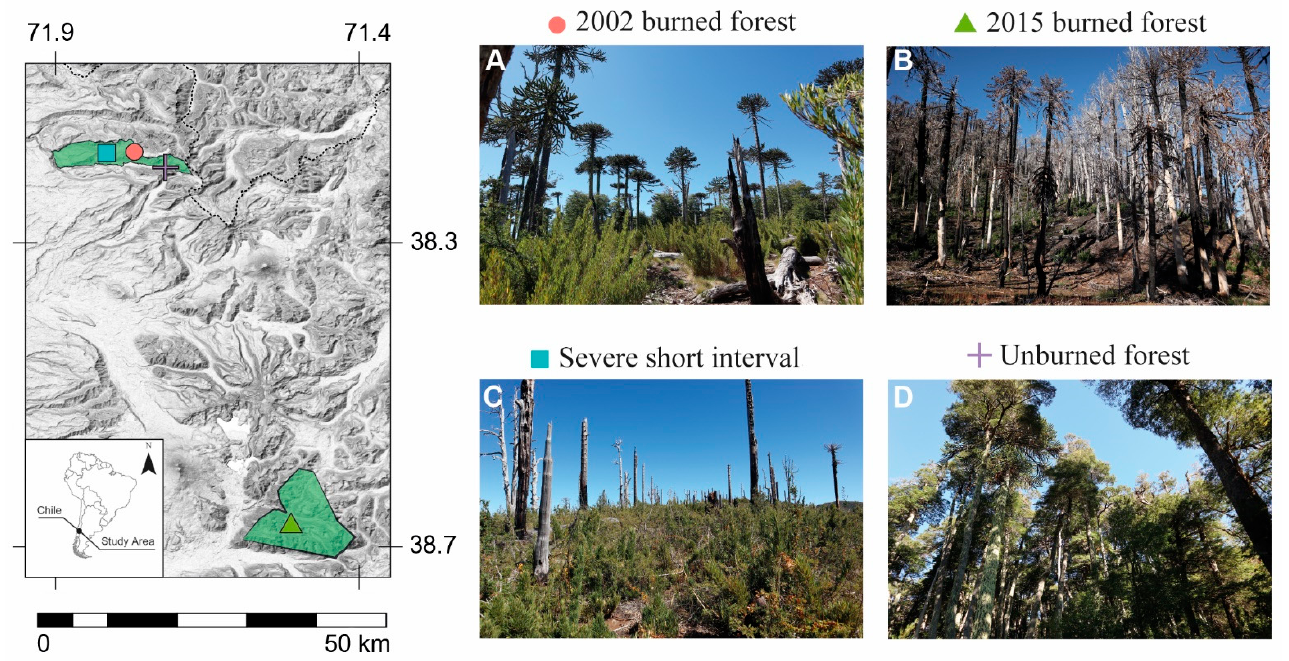
Figure 1. Selected sampling areas in Araucaria – Nothofagus forests from northern Patagonian Chilean landscape. ( A ) Unburned areas; ( B ) short-interval, severe areas (reburned forest); ( C ) 2015-burned areas (recently burned forest); and ( D ) 2002-burned areas (old-burned forest).